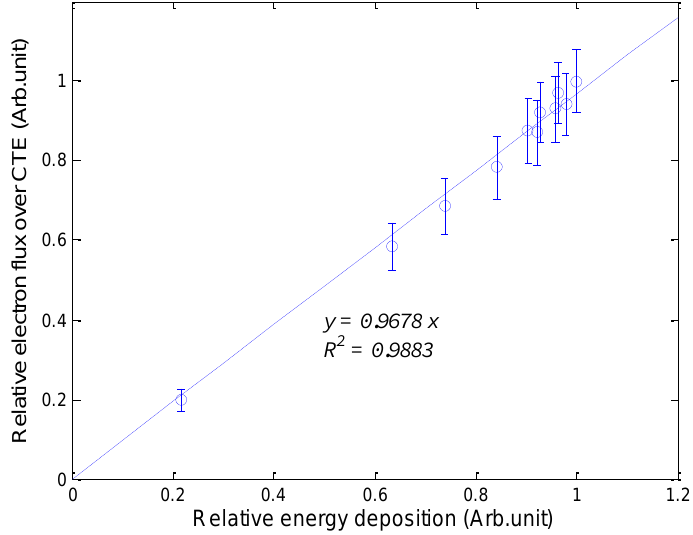
Figure 6. Relationship between fluxes of electrons over the CTE and energy depositions of the gamma-ray